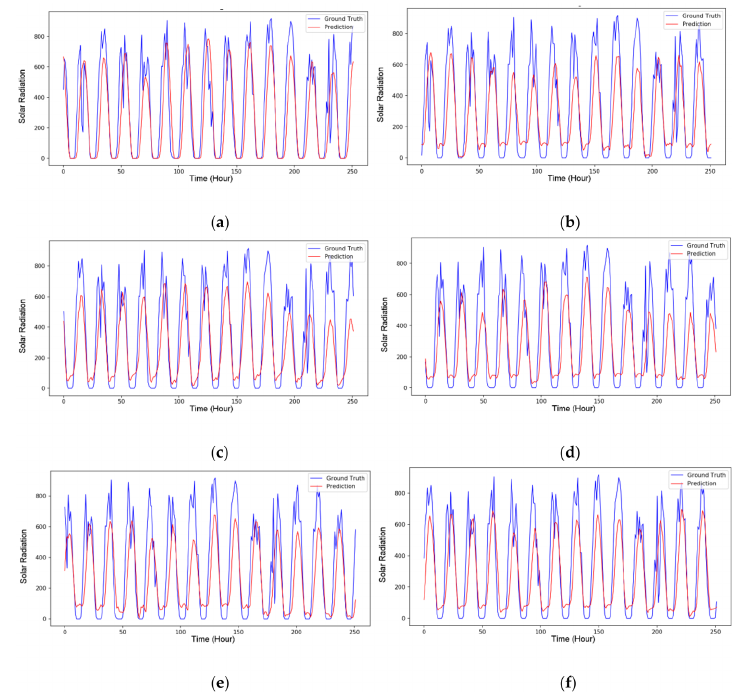
Figure 10. Forecasting results of random forest: ( a ) Partial results A; ( b ) Partial results B; ( c ) Partial results C; ( d ) Partial results D; ( e ) Partial results E; ( f ) Partial results F.